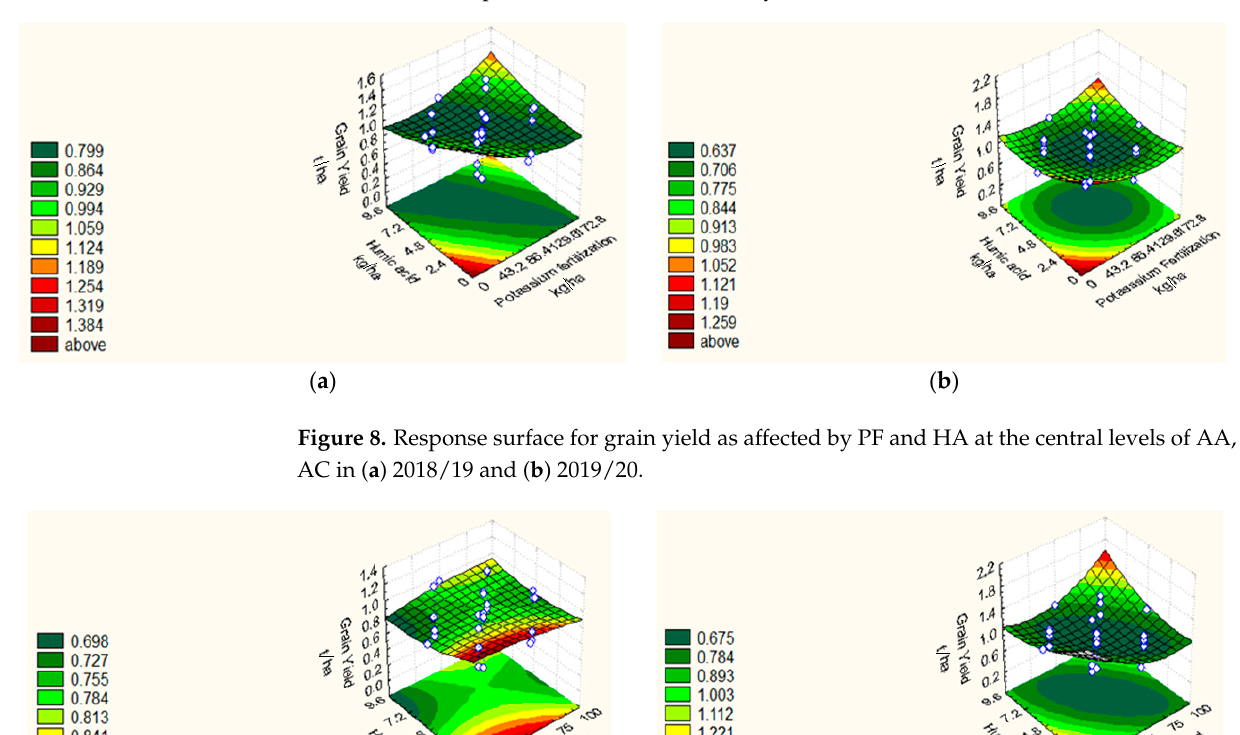
Figure 7. Response surface for 100-grain weight ( a ), number of spikes m − 2 ( b , c ) and plant height ( d , e ) in the two respective seasons as affected by AA and AC at the central levels of AA and HA.